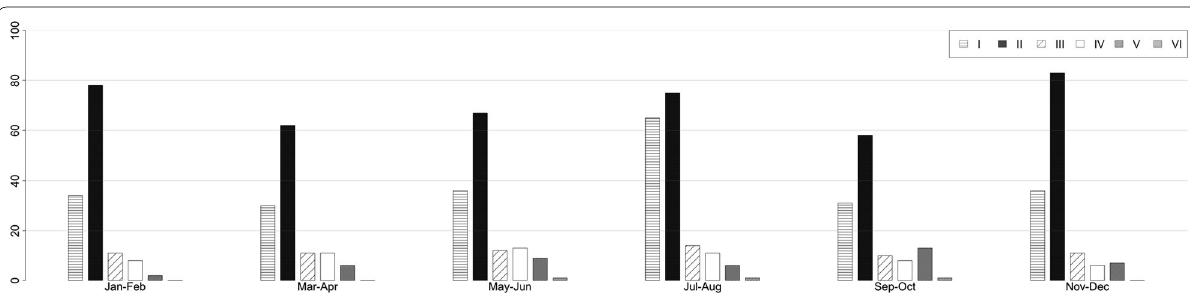
Fig. 2 Yearly distribution of DRFs according to trauma mechanism in a 2-month classification period. DRFs, distal radius fractures. I, low-energy trauma that occurred in a public place; II, low-energy trauma that occurred at home; III, sports trauma; IV, high-energy trauma resulting from car and pedestrian accident; V, work-related injuries; VI, trauma resulting from assault, beatings, or